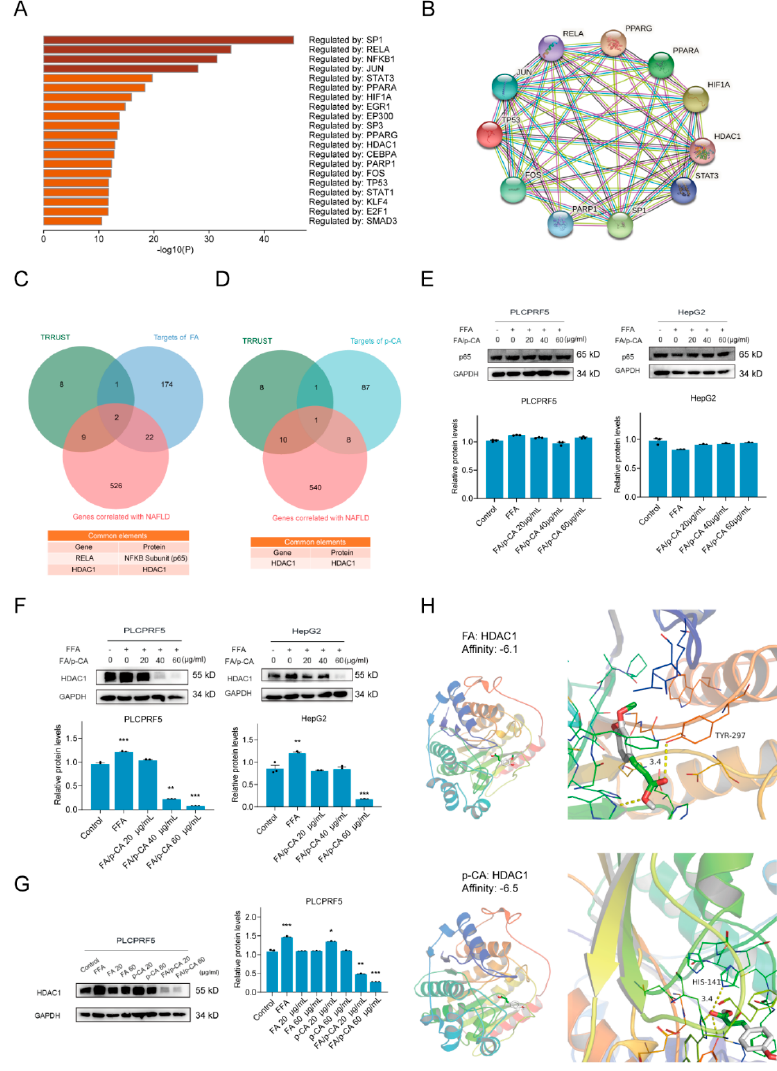
Figure 5. HDAC1 is involved in the amelioration of NAFLD by FA/p-CA. ( A ) Summary of enrichment for TRRUST categories when 558 NAFLD-related targets were uploaded to Metascape, colored with p -values; the color becomes lighter as the p -value increases. ( B ) PPI network of transcriptional regulators. ( C , D ) FA ( C ) or p-CA ( D ) target genes were intersected with TRRUST and NAFLD-related genes by the VENNY tool. ( E , F ) The expressions of p65 ( E ) and HDAC1 ( F ) in FFA-stimulated PLCPRF5 and HepG2 cells were detected by different concentrations of FA/p-CA (0, 20, 40, 60 μ g/mL). Relative protein levels were analyzed using ImageJ software. Data represented as mean ± SD. ( G ) The PLCPRF5 cells were, respectively, exposed to increasing concentrations of FA, p-CA, and FA/p-CA, and then the expression of HDAC1 was determined by Western blot. Expression of GAPDH was used as the internal control. A representative result from three independent experiments was shown. Relative protein levels of HDAC1 were analyzed using ImageJ software. Data represented as mean ±